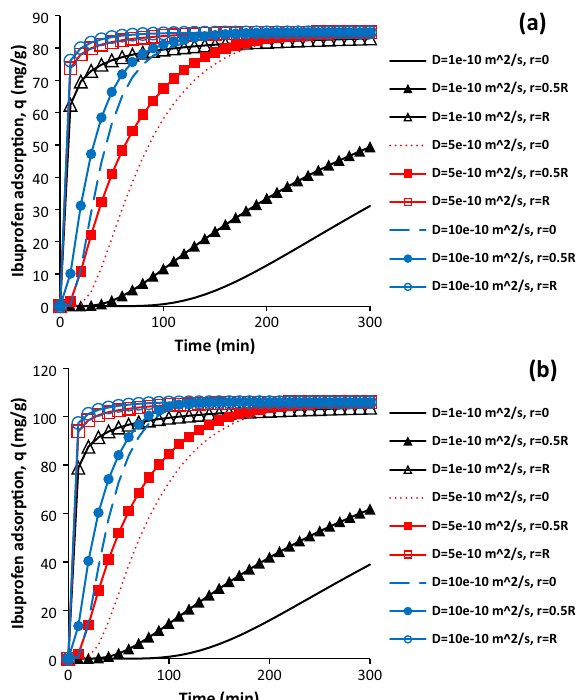
Figure 8. Effect of solute diffusion coefficient on the ibuprofen adsorption for AC ( a ) and SAC ( b ), initial ibuprofen concentration = 100 mg/L, T = 298 K, pH = 2, AC porosity = 0.392, SAC porosity = 0.474, adsorbent dosage of 0.5 g/L, and particle radius = 163 µm.